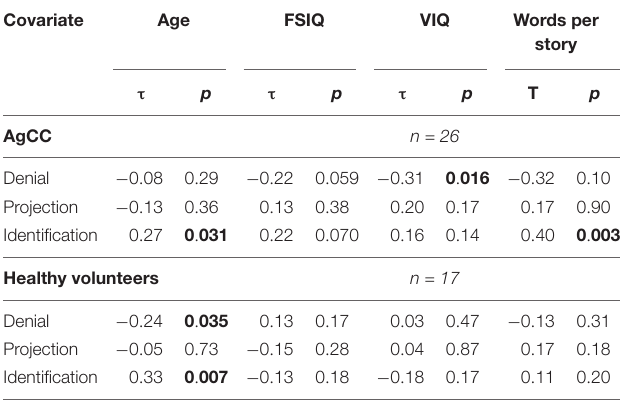
TABLE 3 | Rank-order correlations of Relative Defense Scores with age, FSIQ, VIQ and words per story (two-tailed p-values for Projection). Covariate Age FSIQ VIQ Words per